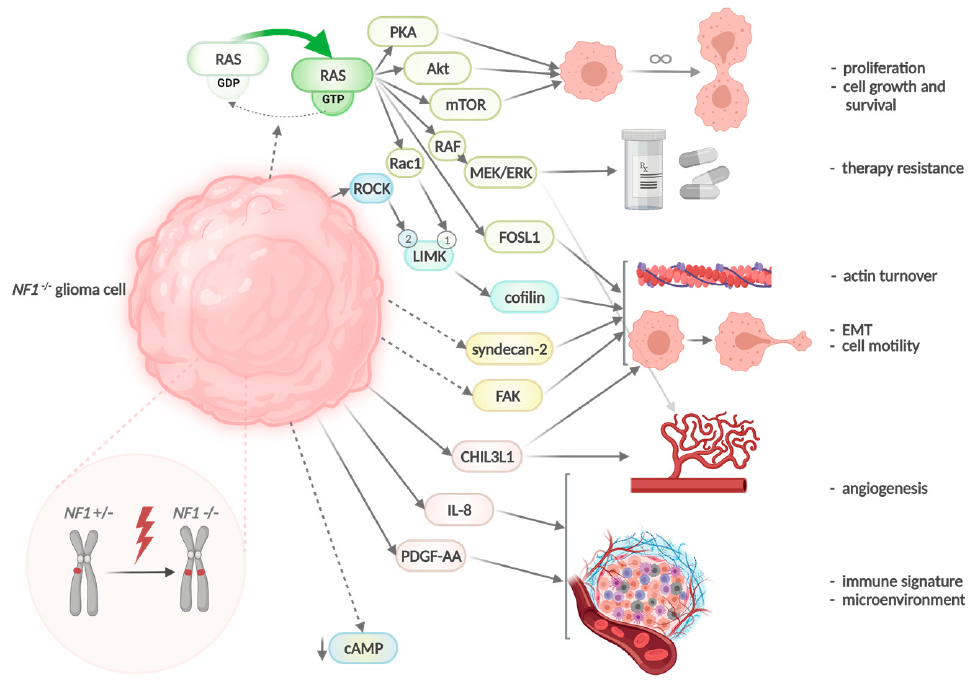
Figure 4. A consequence of NF1 loss of function in cancer: NF1 deficiency prevents inactivation of Ras through GTP hydrolysis and leads to upregulation of Ras signalling. It is associated with increased tumour proliferation, EMT, invasion, cell motility, and therapy resistance. Moreover, the hyperphosphorylation of LIMK1 in Ras- or LIMK2 in a ROCK-dependent manner results in the activation of cofilin pathways, which leads to changes in actin cytoskeleton and cell motility. The inability of the C-terminal domain of neurofibromin to bind to focal adhesion kinase and syndecan-2 induces cell detachment and might facilitate the epithelial to mesenchymal transition. This process is supported by the upregulation of FOSL1 and increased secretion of chitinase-3-like protein 1 (CHI3L1). Loss of NF1 changes also the tumour microenvironment and angiogenesis by the enhanced secretion of platelet-derived growth factor AA (PDGF-AA) and interleukin-8 (IL-8). In patients with NF1, the somatic NF1 hit accompanies a germline mutation ( NF1 -/- ), which corresponds to a complete loss of function of neurofibromin, a classical tumour suppressor. In non-NF1-associated NF1 -altered GBM, the somatic NF1 hit accompanies other primary genetic alterations that might act similar, e.g., affect the MAPK pathway. Created with BioRender (ZE2345L4TH, 24 October 2021). Patients with autosomal dominantly inherited NF1 are prone to develop benign pe- ripheral nerve tumours known as neurofibromas, which is the hallmark of the disease. Cutaneous neurofibromas arise due to mutations of both copies of the NF1 tumour suppres- sor gene in Schwann cells (biallelic inactivation). It is important to point out that only the Schwann cells are NF1 -/- , while other components within the microenvironment are NF1 +/- [85]. The development of NF1 and the subsequent reprogramming of Schwann cells have been extensively reviewed and are not the focus of this review [75,86–91]. Other NF1- associated tumours comprise plexiform neurofibromas (30–50%), optic pathway gliomas (15–20%), MPNST (10–15%), and others [73,92]. Recently, diagnostic criteria have been updated [93]. The mutational spectrum includes missense or nonsense mutations (33%), small deletions (26%), splicing substitutions (15%), small insertions/duplications (11%), and gross deletions (over 20 bp, 11%). About half of all NF1 patients display new mutations. In principle, NF1-associated benign lesions in NF1 patients acquire a somatic NF1 loss of heterozygosity (LOH) to be initiated, which accompanies the germline NF1